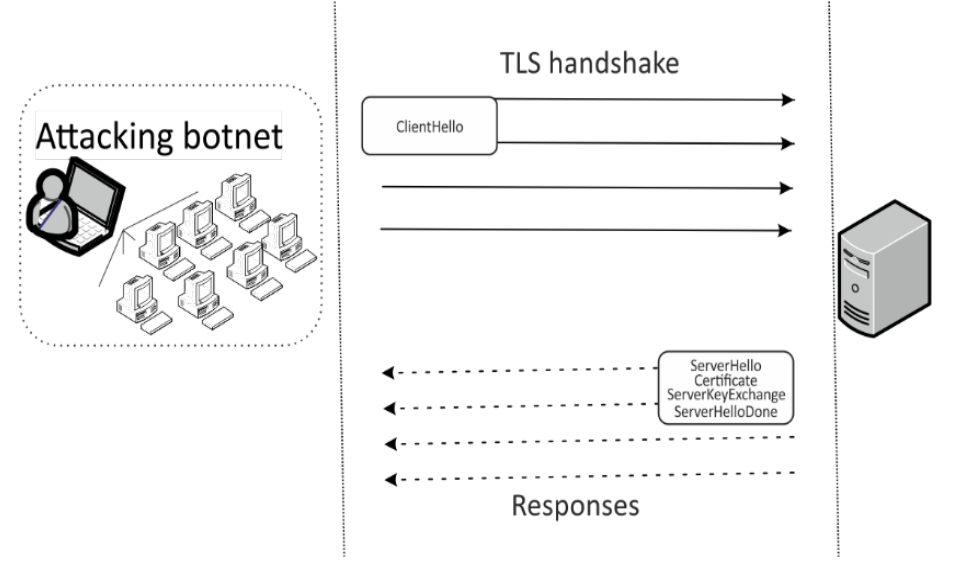
Figure 4. SSL/TLS flood DDoS attack.